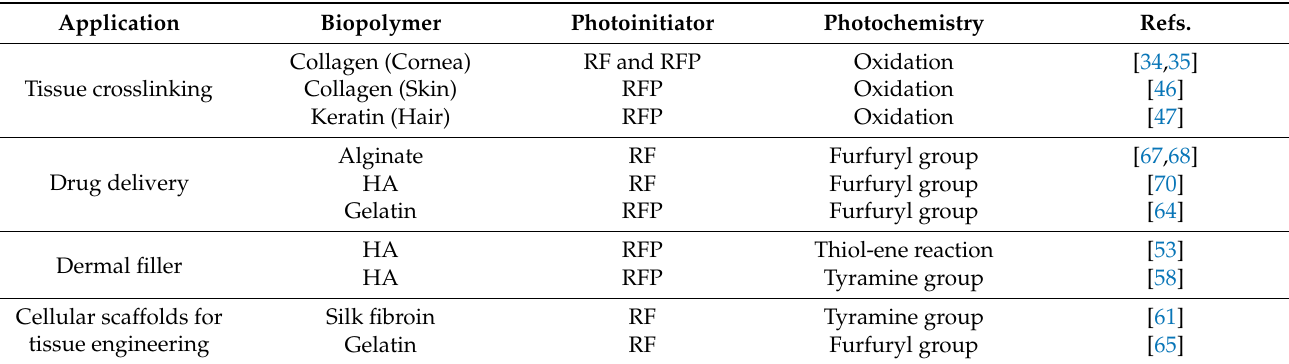
Table 3. Biomedical applications of RF-induced